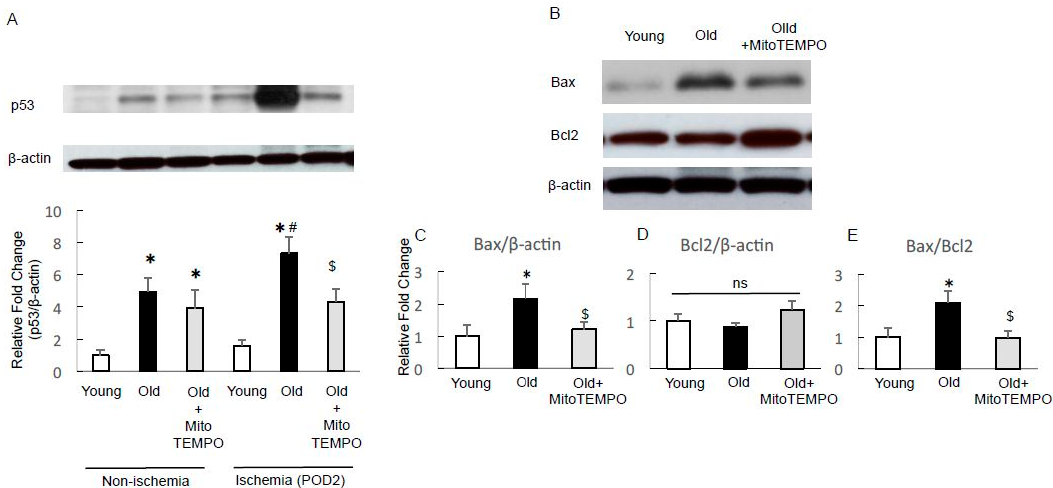
Figure 6. The protein expressions of p53, B-cell leukemia/lymphoma 2 (Bcl2) and Bcl2-associated X (Bax). The expression of p53 was analyzed by Western blotting in non-ischemic and ischemic (POD 2) skeletal muscle from young, old, and MitoTEMPO-treated old mice. The p53 expression was higher in old mice compared to young mice for non-ischemic and ischemic (POD 2) skeletal muscles. MitoTEMPO treatment attenuated the elevation of p53 after induction of ischemia ( A ). The expression of the proapoptotic factor Bax and the antiapoptotic factor Bcl2 was analyzed by Western blotting in the ischemic (POD 2) skeletal muscles of young, old, and MitoTEMPO-treated old mice. Representative images of Bax and Bcl2 ( B ) and the summarized findings after quantification of Bax/ β -actin ( C ); Bcl2/ β -actin ( D ) and Bax/Bcl2 ( E ). The Bax/Bcl2 ratio was significantly higher in old mice compared to young mice. MitoTEMPO treatment decreased the Bax/Bcl2 ratio to a similar level to that of young mice. The values are expressed as the means ± S.E.M. n = 10, each. * p < 0.05 vs. young mice, $ p < 0.05 vs. old mice, # p < 0.05 vs. non-ischemic skeletal muscle. ns indicates no significant difference.